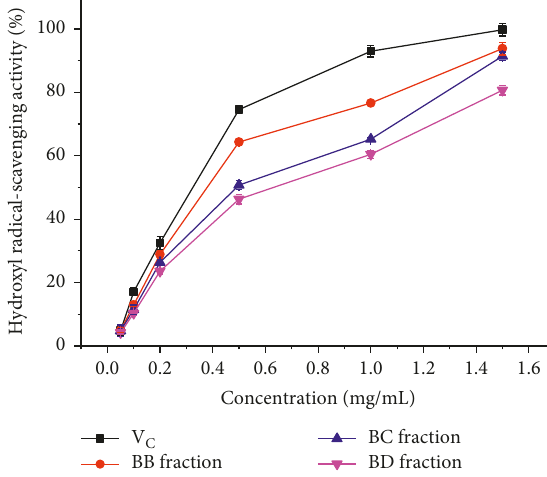
Figure 9: Hydroxyl radical-scavenging activity of V BD C .